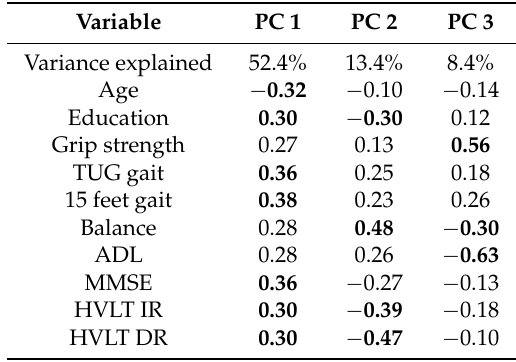
Table 4. Variance explained and factor loadings for the first 3 components. Significant variables with a factor of at least 0.3 are highlighted in bold. Abbreviations: ADL—activities of daily living, MMSE—Mini Mental Status Exam, HVLT—Hopkins Verbal Learning Test (IR—Immediate Recall,